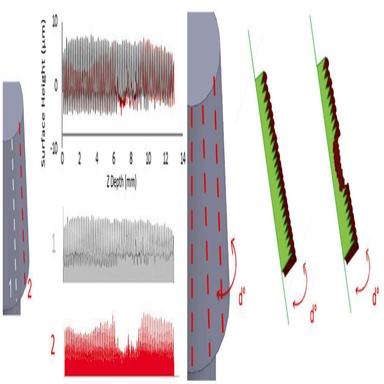
Left - Profile with no material loss (1) and profile with material loss (2) showing repair (above) Right – Projection of profiles over a partial annulus to calculate material loss.